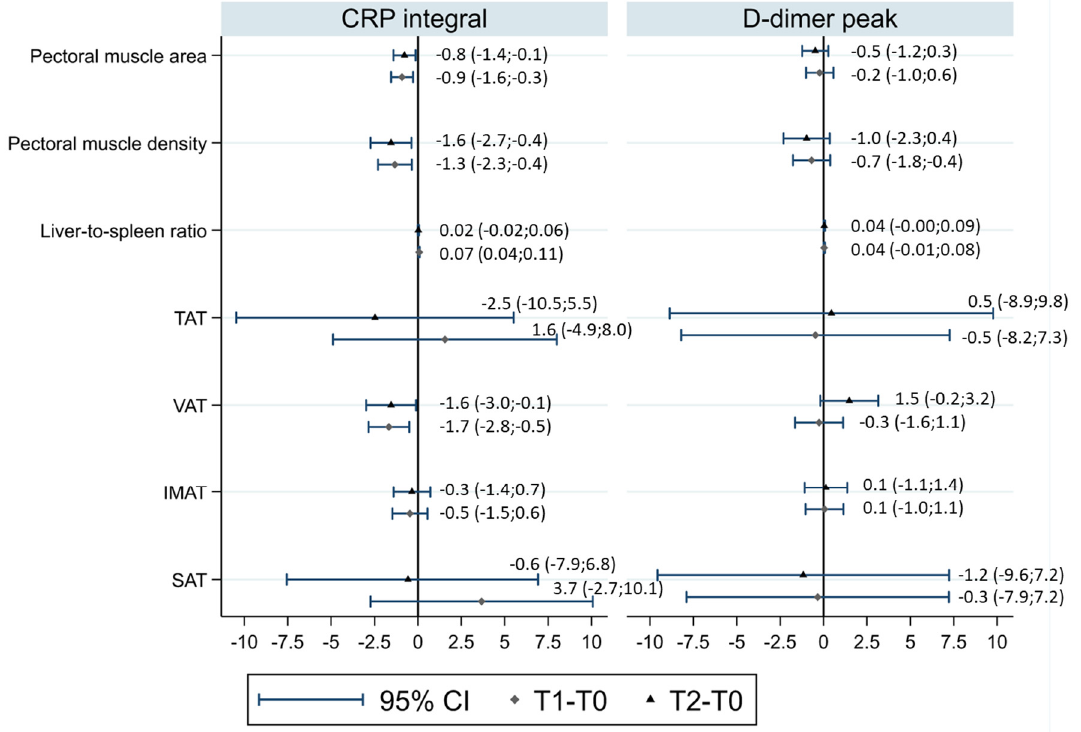
Figure 3. Associations of CRP intervals and D-dimer peaks with CT body composition changes in models adjusted for age, sex, and baseline TAT. Each diamond represents the linear regression coefficient (and the corresponding 95% confidence interval (CI)) of the CRP intervals and D-dimer peaks for CT body composition changes in T1–T0, and each triangle represents the linear regression coefficient of the CRP intervals and D-dimer peaks for CT body composition changes in T2–T0. TAT, total adipose tissue area; VAT, visceral adipose tissue area; SAT, subcutaneous adipose tissue area; IMAT, intermuscular adipose tissue area.